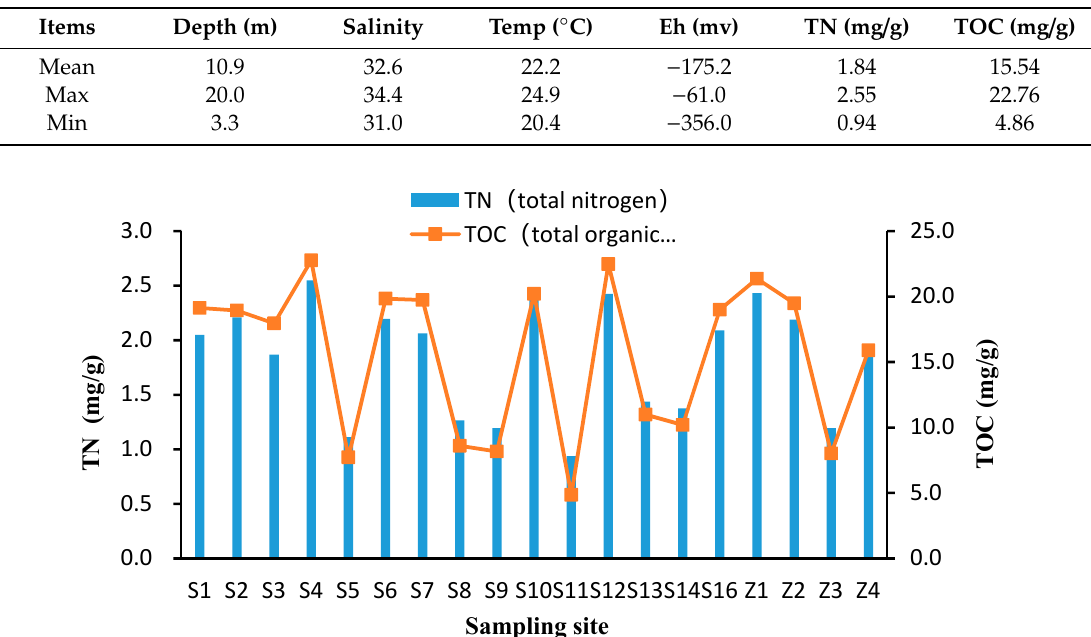
Figure 2. Dynamics of total nitrogen (TN) and total organic carbon (TOC) in the surface sediments of Daya Bay, China.